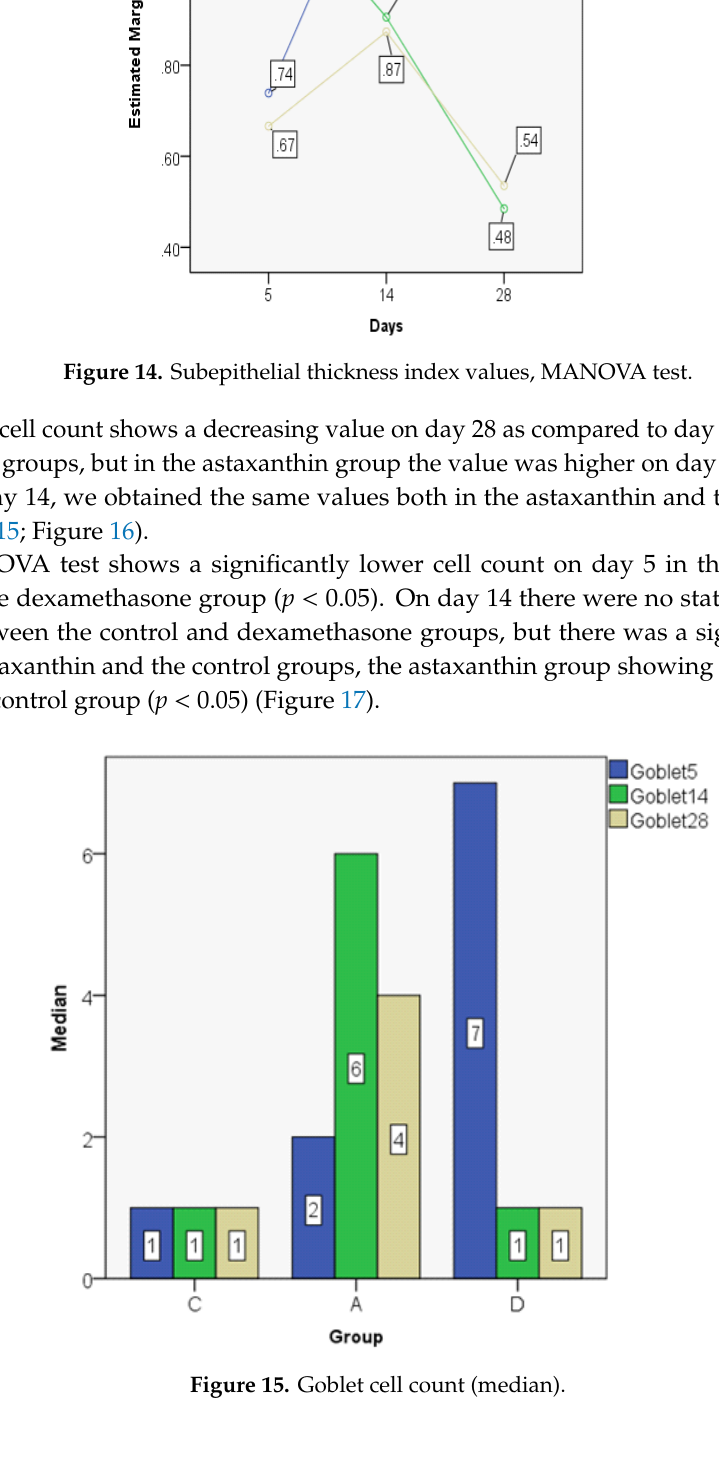
Figure 16. Goblet cell count (boxplot representation).